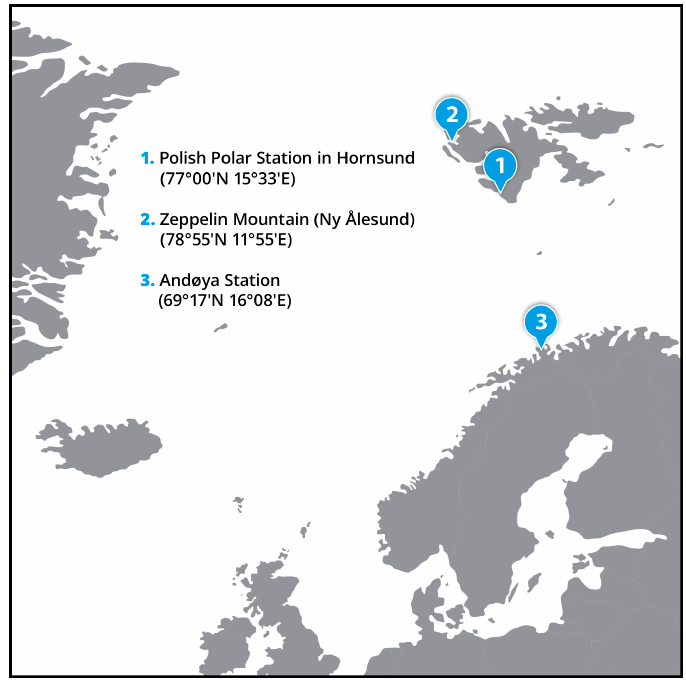
Figure 4. Location of the Polish Polar Station at Hornsund fjord in relation to other stations conducting research on PAHs compounds.